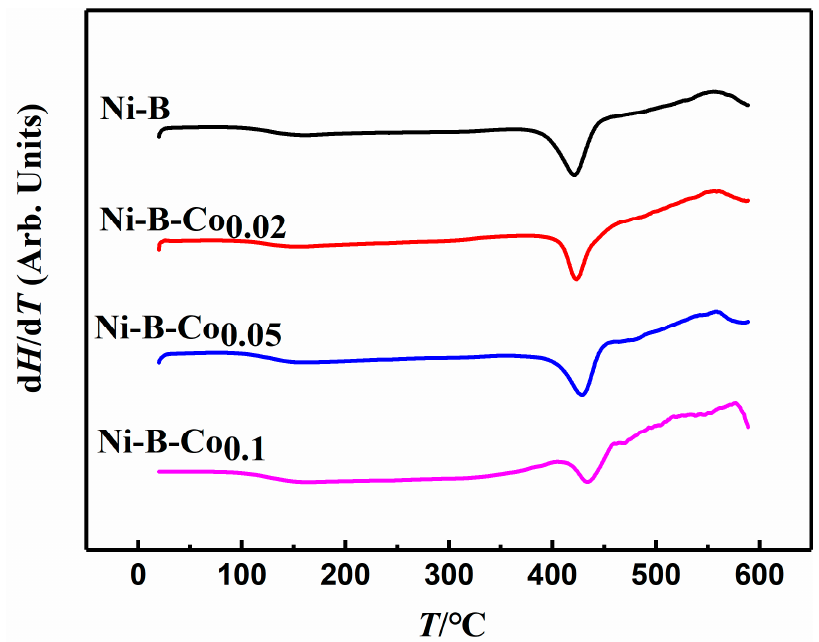
Figure 2. DSC patterns of the Ni-B and Ni-B-Co nanoparticles.